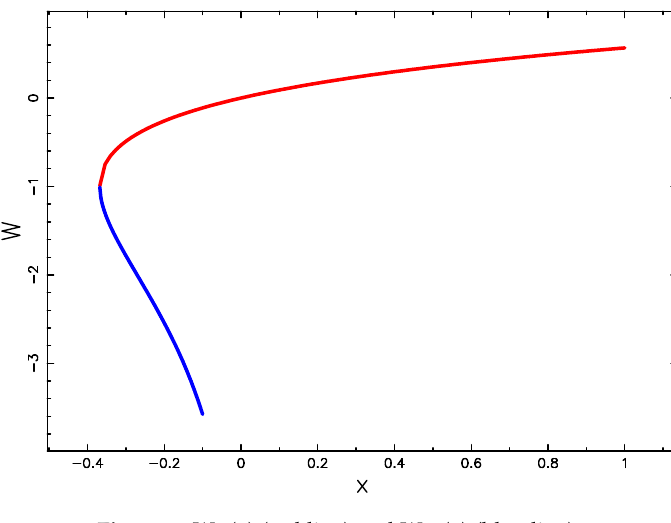
Figure 1. Wp(x) (red line) and Wm(x) (blue line).